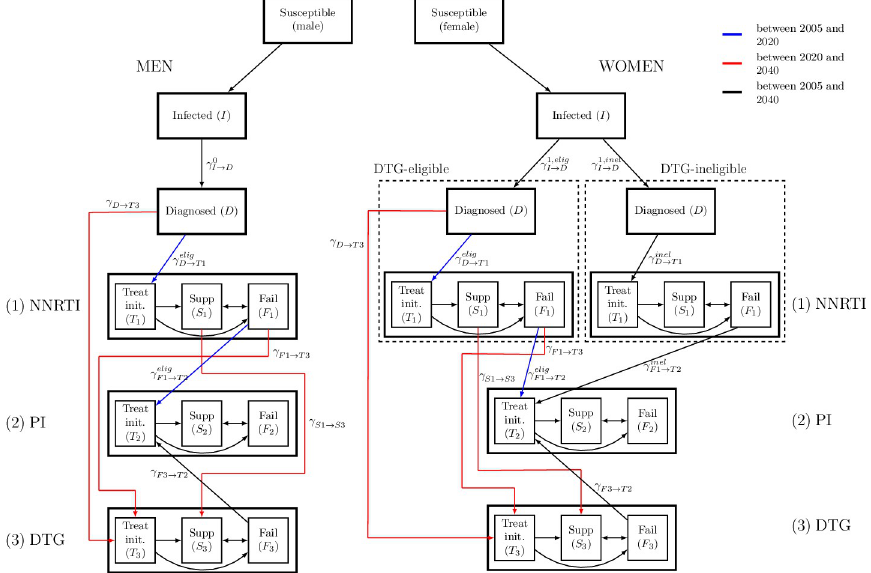
Fig 1. The adapted MARISA model. The model differentiates DTG-eligible from DTG-ineligible women. The model structure related to the cascade of care is shown. DTG, dolutegravir; MARISA, Modeling Antiretroviral drug Resistance In South Africa; NNRTI, non-nucleoside reverse transcriptase inhibitor; PI, protease inhibitor.